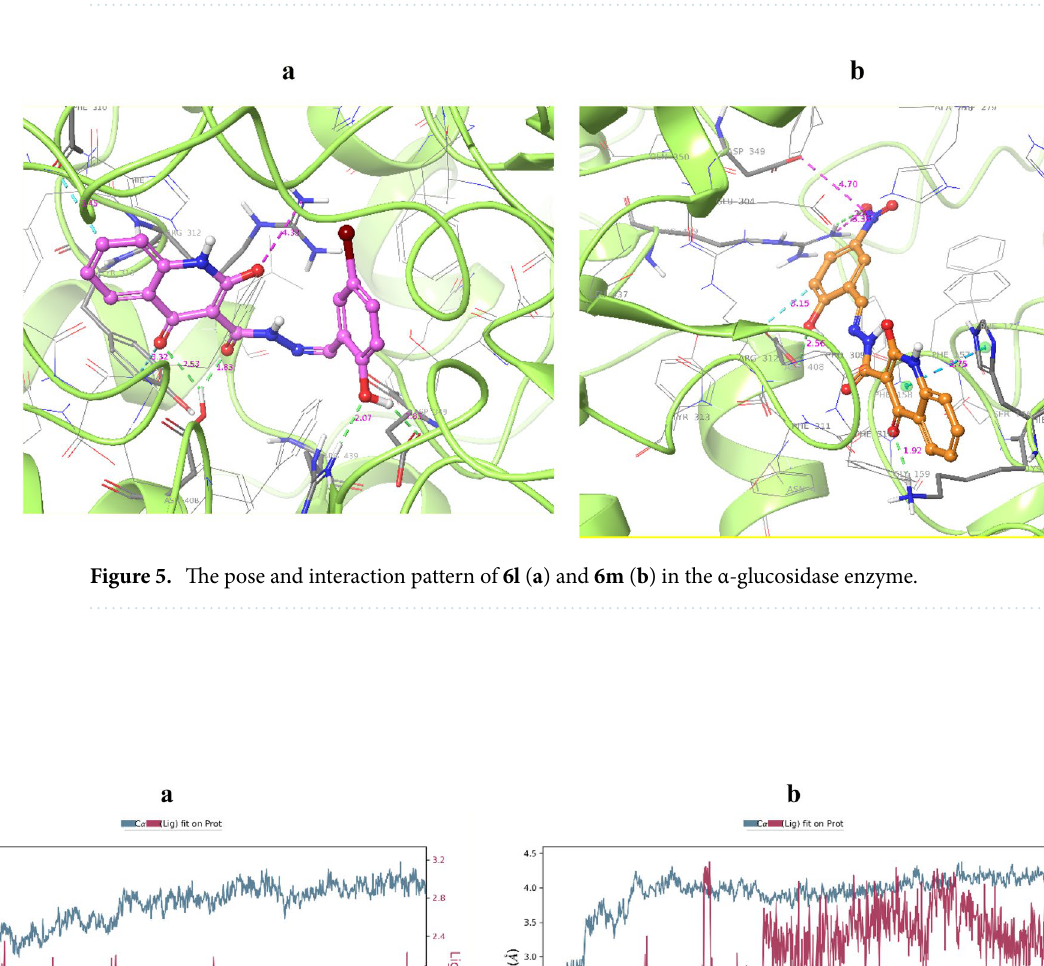
Table 2. The predicted binding energy of 6l and 6m derivatives with the desired enzyme.